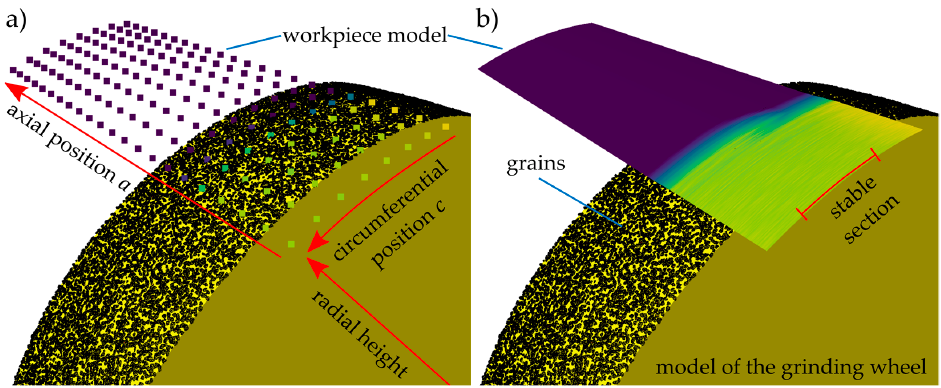
Figure 10. Visualisation of the tool and workpiece models. ( a ) Only every 200th point in every dimension of the grid is visible, ( b ) Every height value is rendered.